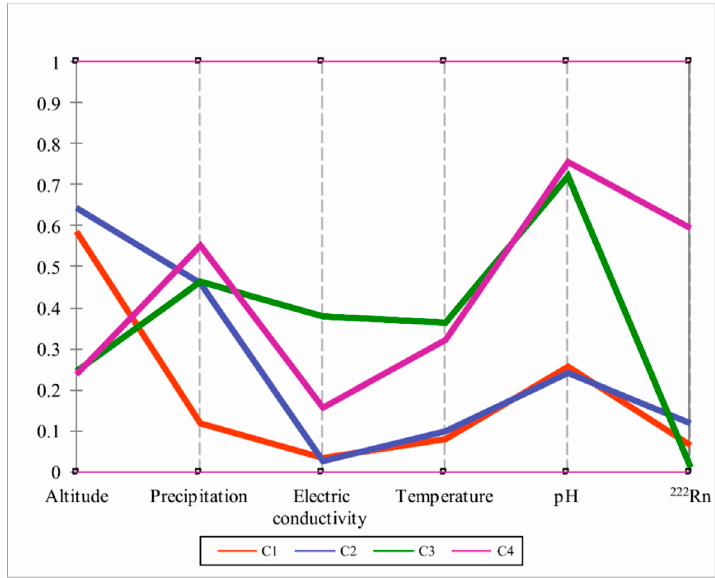
Figure 7. The distribution of clustering results through parallel coordinate visualization plots (PCV). An additional explanation is provided in the text.